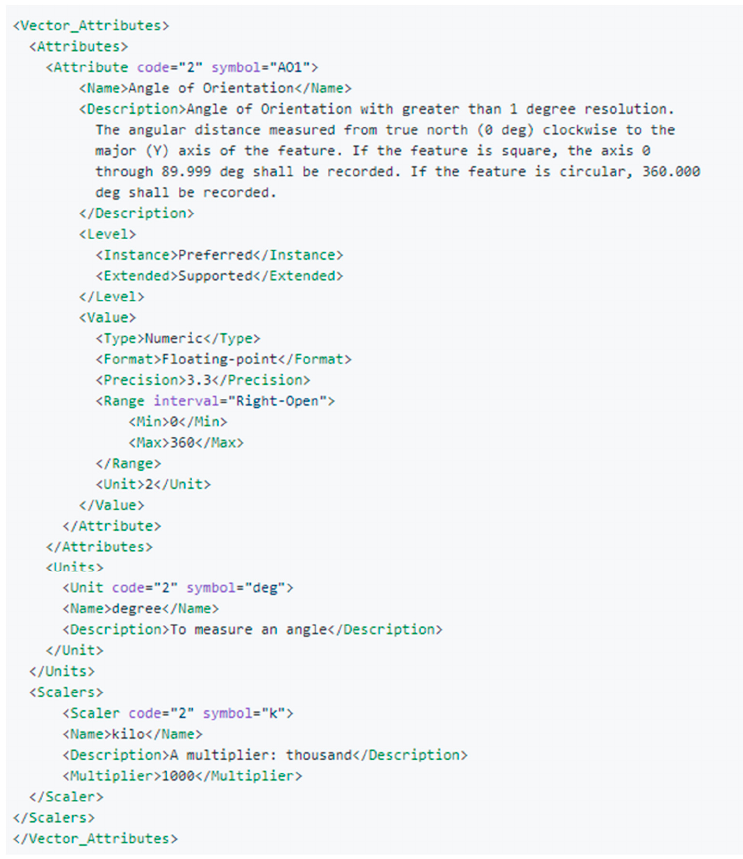
Figure 8. An example of extending the CDB attribution schema for the code 2 and angel of